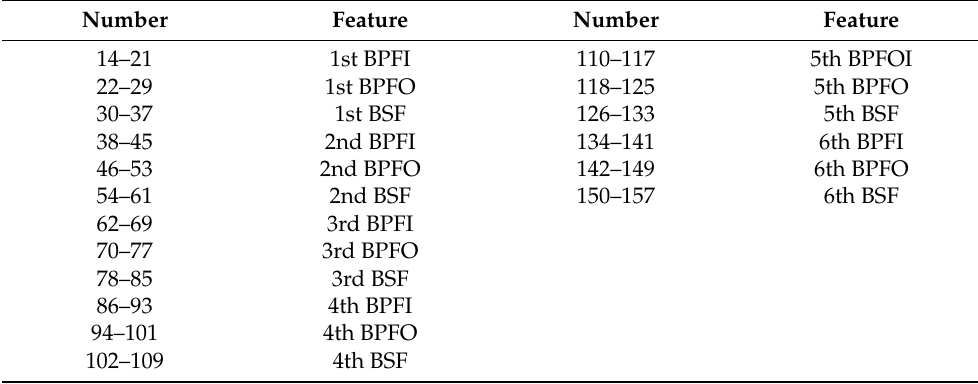
Table 3. Features from